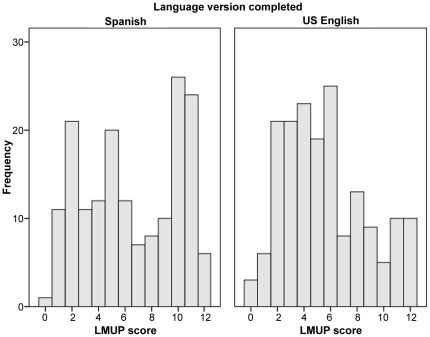
Distribution of English and Spanish London Measure of Unplanned Pregnancy scores in a U.S. population of women.Scores are presented for English (left) and Spanish (right) in Figure 1. All scores were represented in each language. A non-normal distribution was noted for each language.